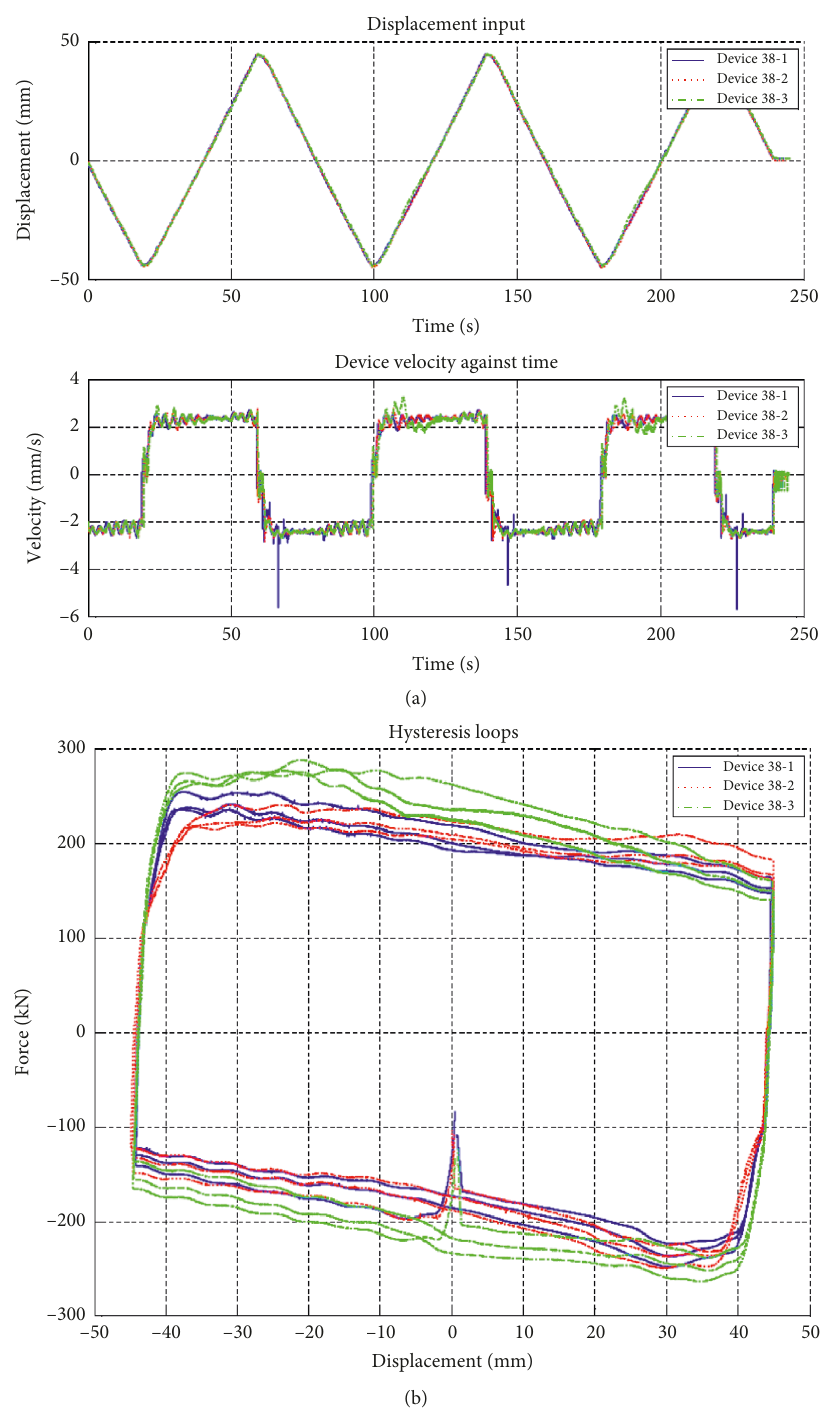
Figure 5: Representative results showing 3 fully reversed cycles at 2.5mm/s device velocity command with inputs of displacement and velocity (a) and resulting hysteresis loops